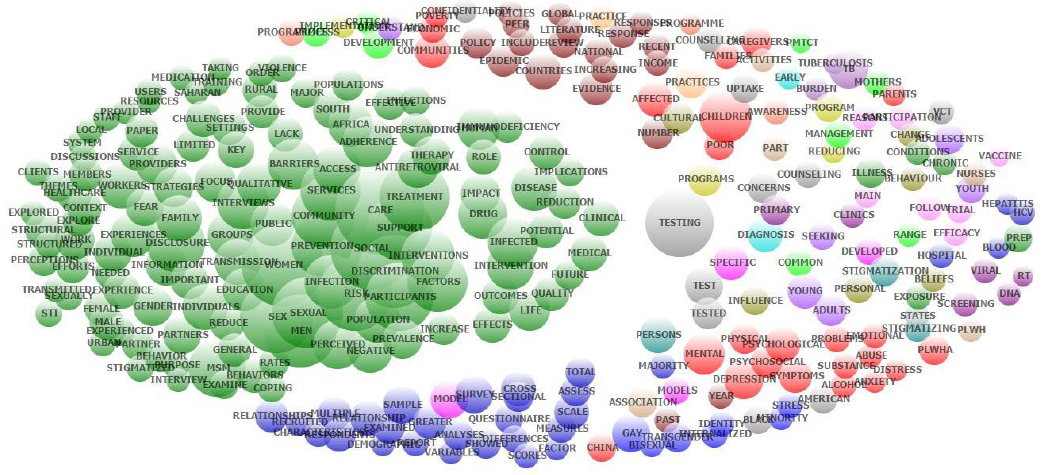
Figure 4. Co-occurrence of most frequent topics emerged from exploratory factor analysis of abstracts